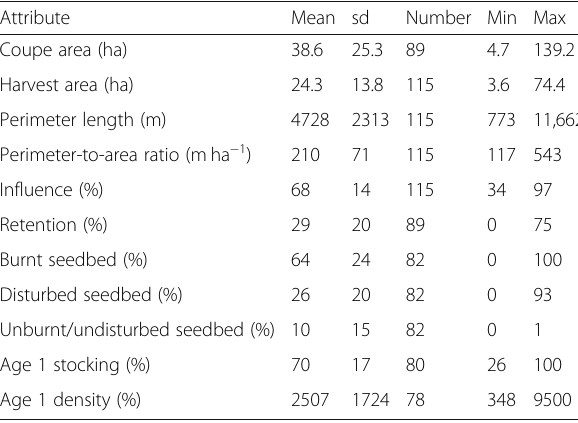
Table 1 Summary statistics for selected attributes of ARN coupes harvested since 2003